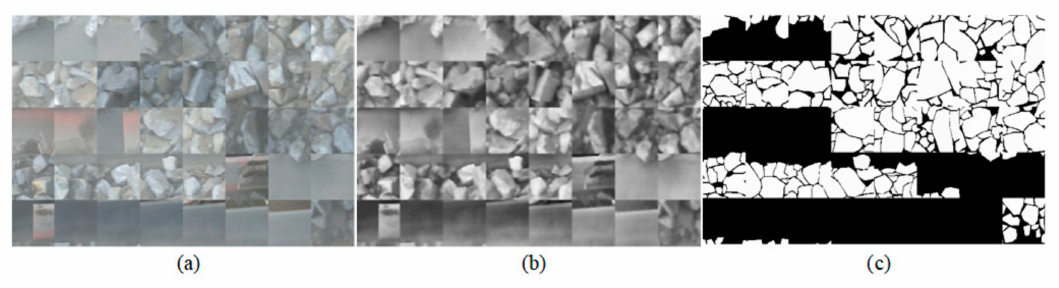
Figure 3. Typical 48 × 48 patches selected for model training: ( a ) shows the patches from the original images; ( b ) shows the patches from the preprocessed image; ( c ) shows the patches from the corresponding ground